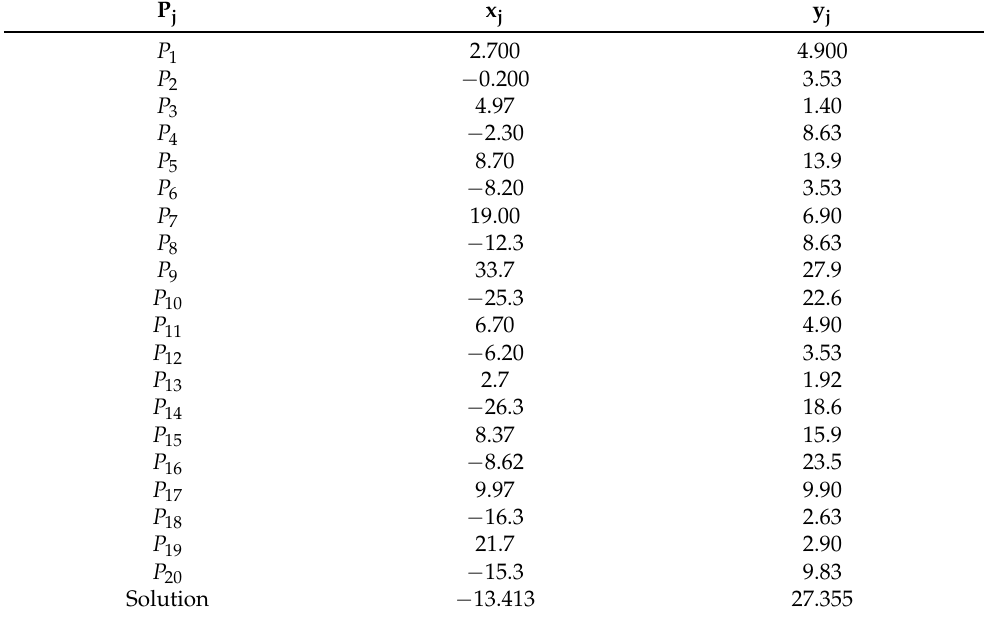
Table 1. F 1 = (5.00,8.00) and F 2 = ( − 5.00,2.00) are given with the equal weighted 20 points (Value is 1). The minimax value is